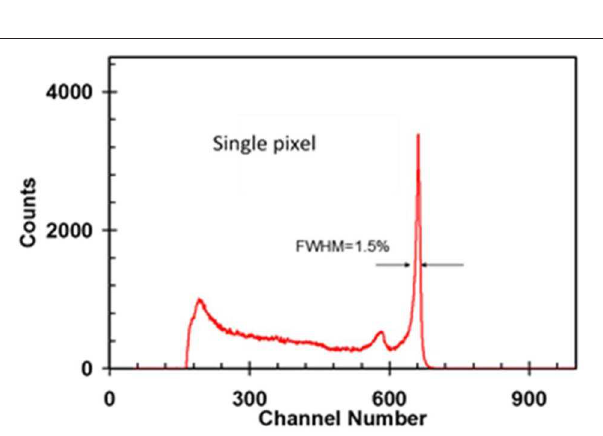
FIGURE 10 | Depth corrected 137 Cs energy spectrum from a 3 × 3 TlBr array (5mm thick, 1mm pitch).